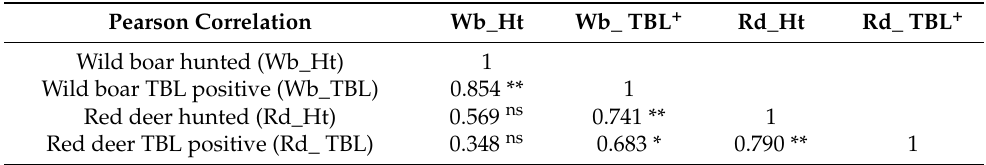
Table 3. Results after correlation analysis for 2006–2016. Pearson Correlation Wb_Ht Wb_ TBL + Rd_Ht Rd_ TBL + Wild boar hunted (Wb_Ht)